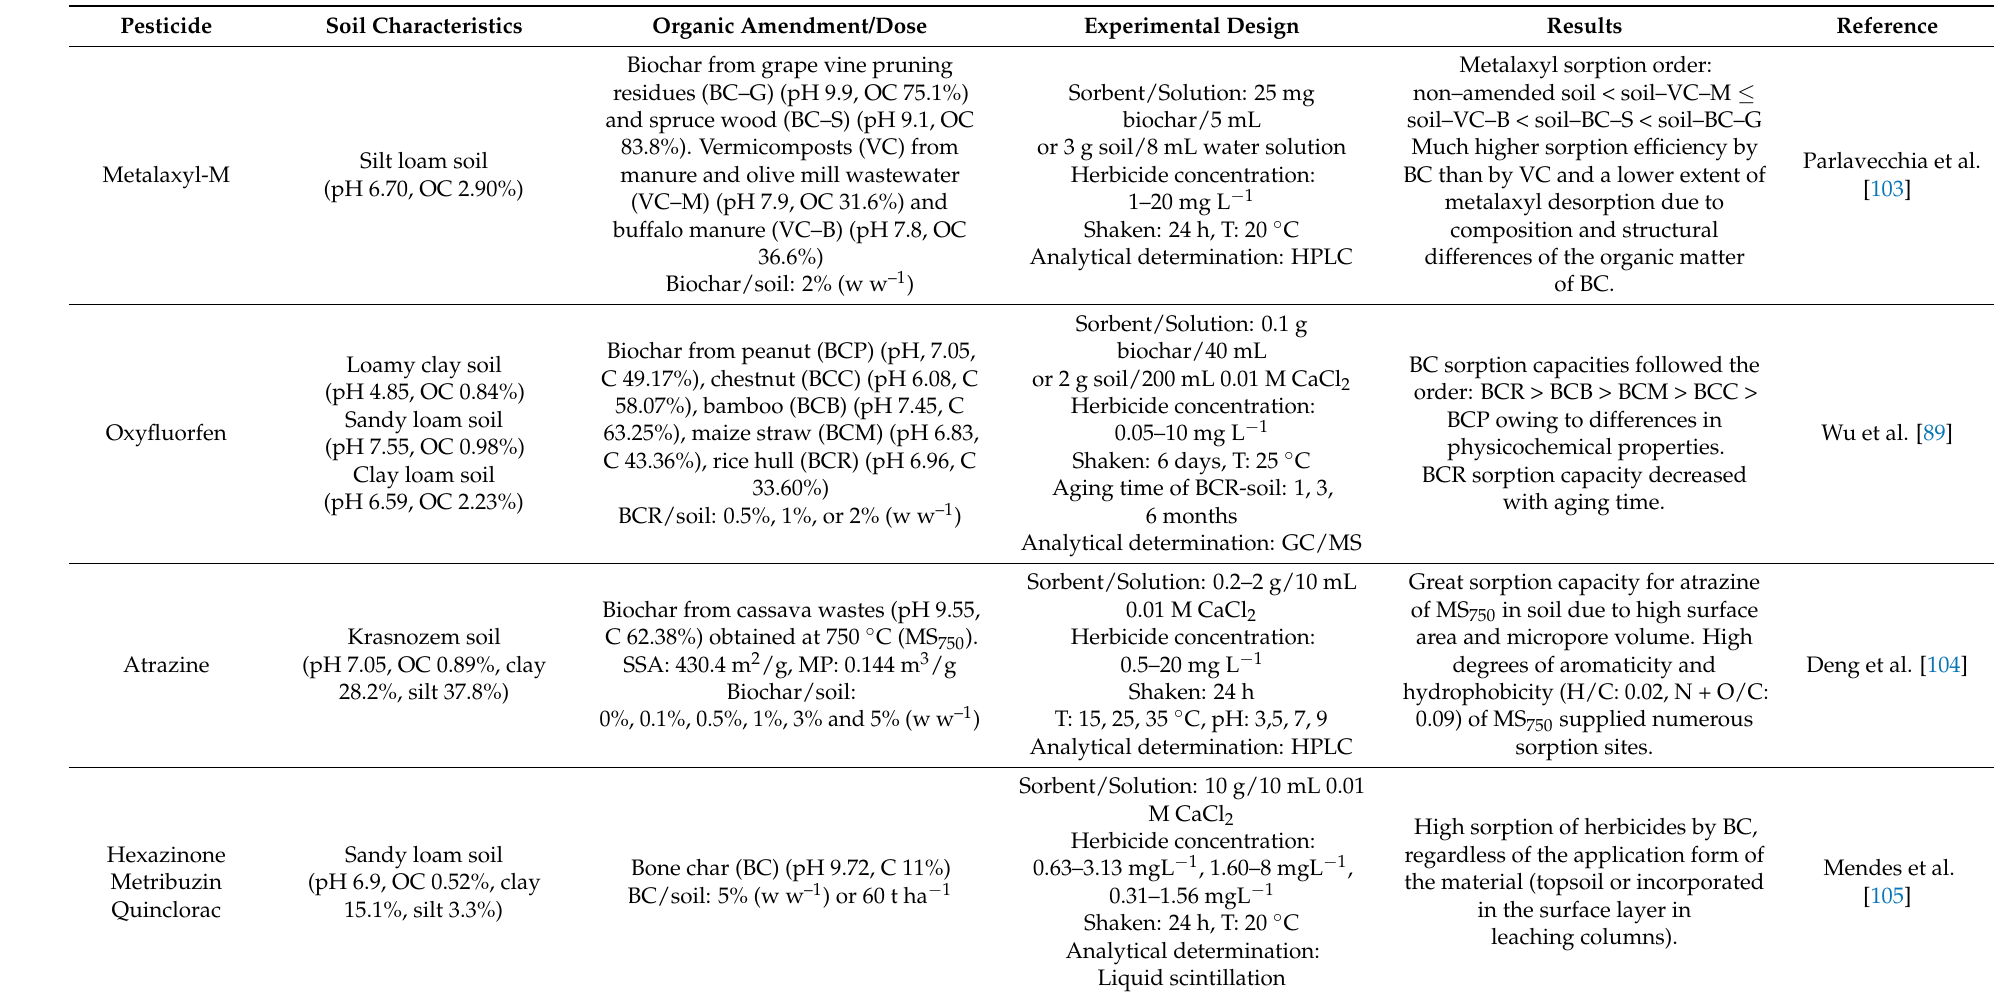
Table 1. Adsorption–Desorption of pesticides by organic residues and amended